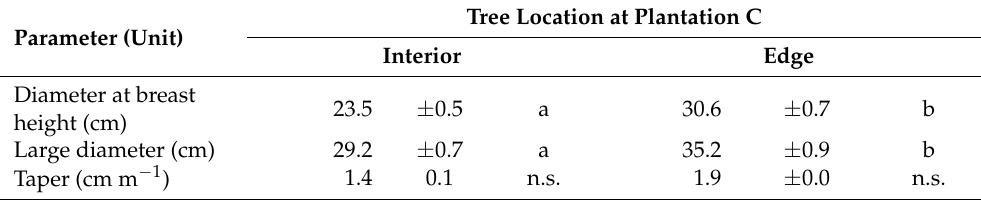
Table 3. Paulownia roundwood characteristics measured for 40 trees, 20 interior and 20 located at the edge of plantation C. Different letters in the cells indicate a statistically significant difference among values measured at the three plantations, while “n.s.” indicates no significant difference.